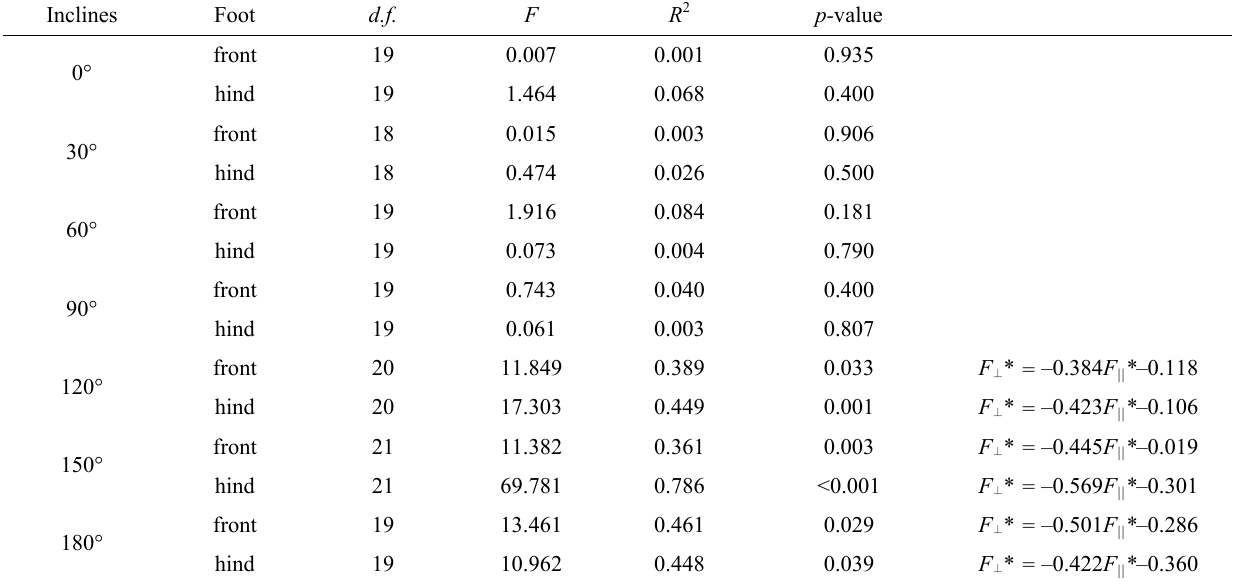
Table 2 The linear regression of critical normal reaction force ( F ⊥ *) on critical shear reaction force ( F || *) acting on front and hind feet of gecko at different